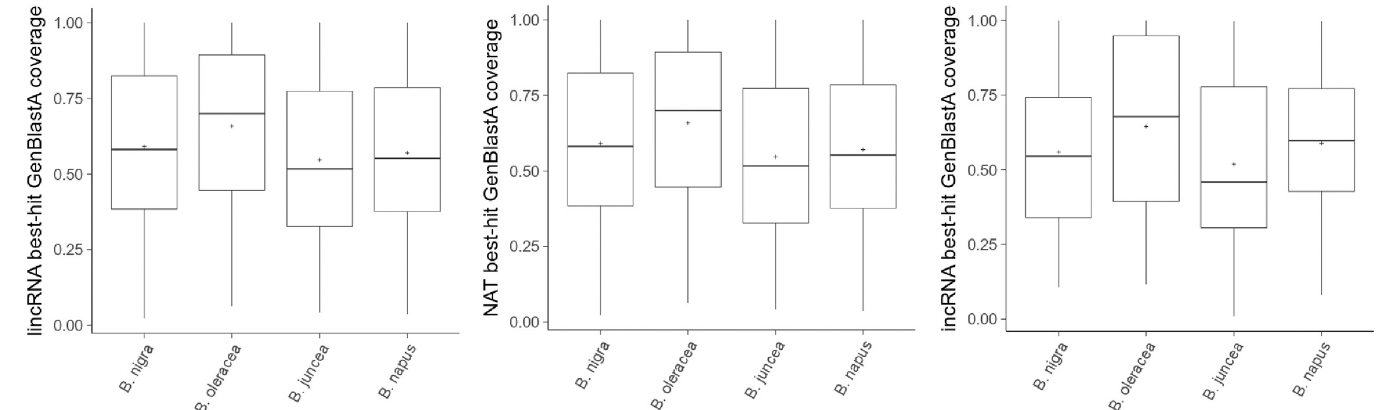
Fig 7. BLAST search of each type of lncRNA from B . rapa against B . nigra , B . oleracea , B . juncea , and B . napus .